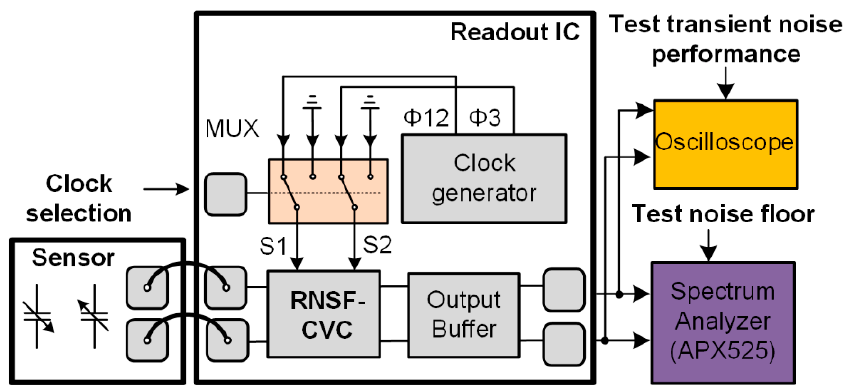
Figure 15. The test configuration of the readout IC.